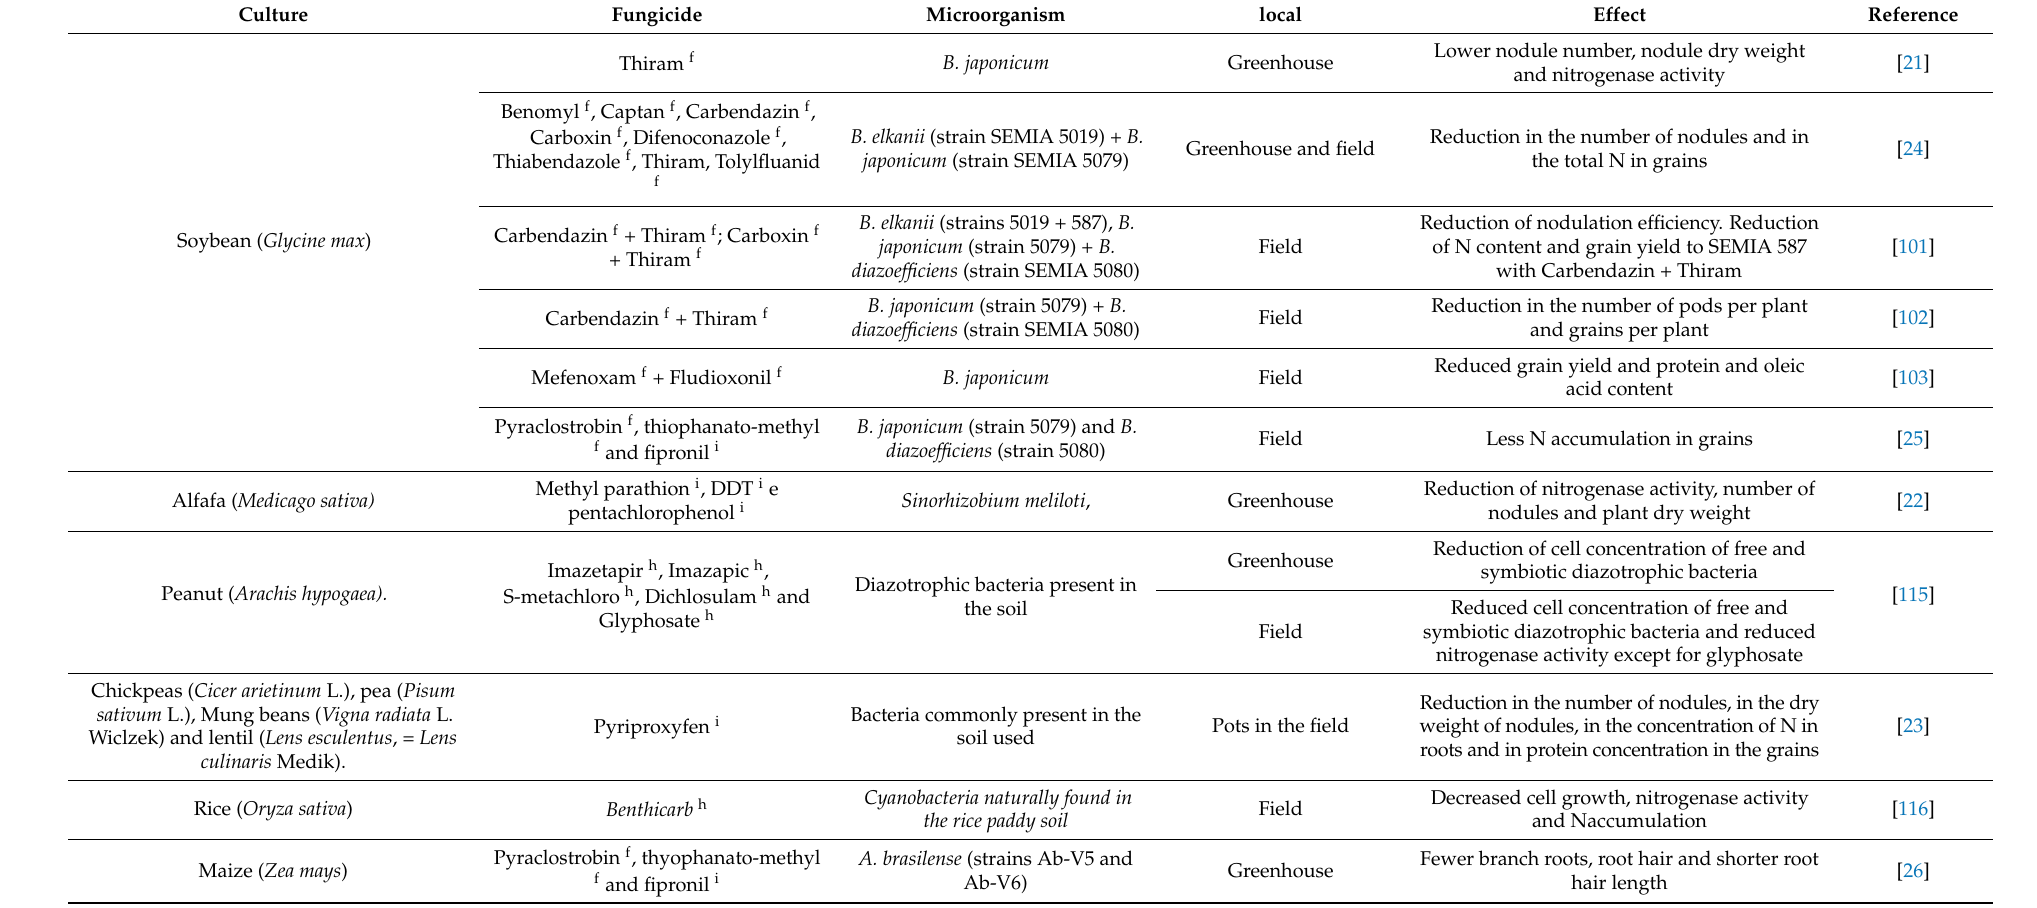
Table 2. Effect of pesticides on the development of plants the seeds of which had been